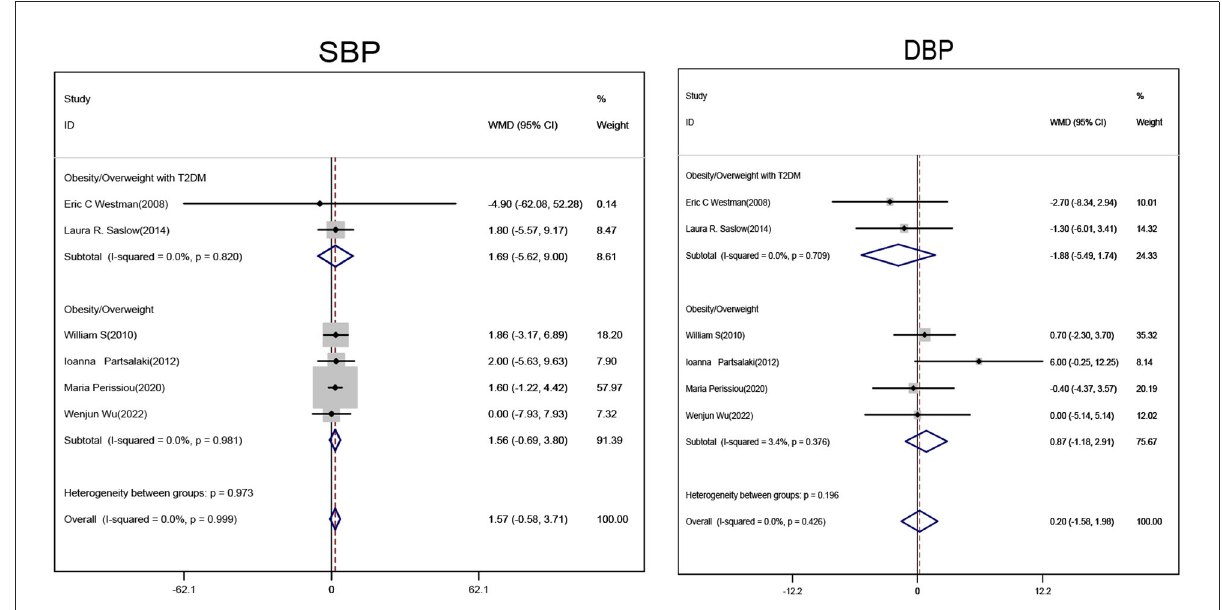
FIGURE5 Forest plot showing weighted mean difference and 95% confidence intervals (CIs) for low carbohydrate ketogenic diet effects on blood pressure. SBP, Systolic pressure; DBP, Diastolic pressure.